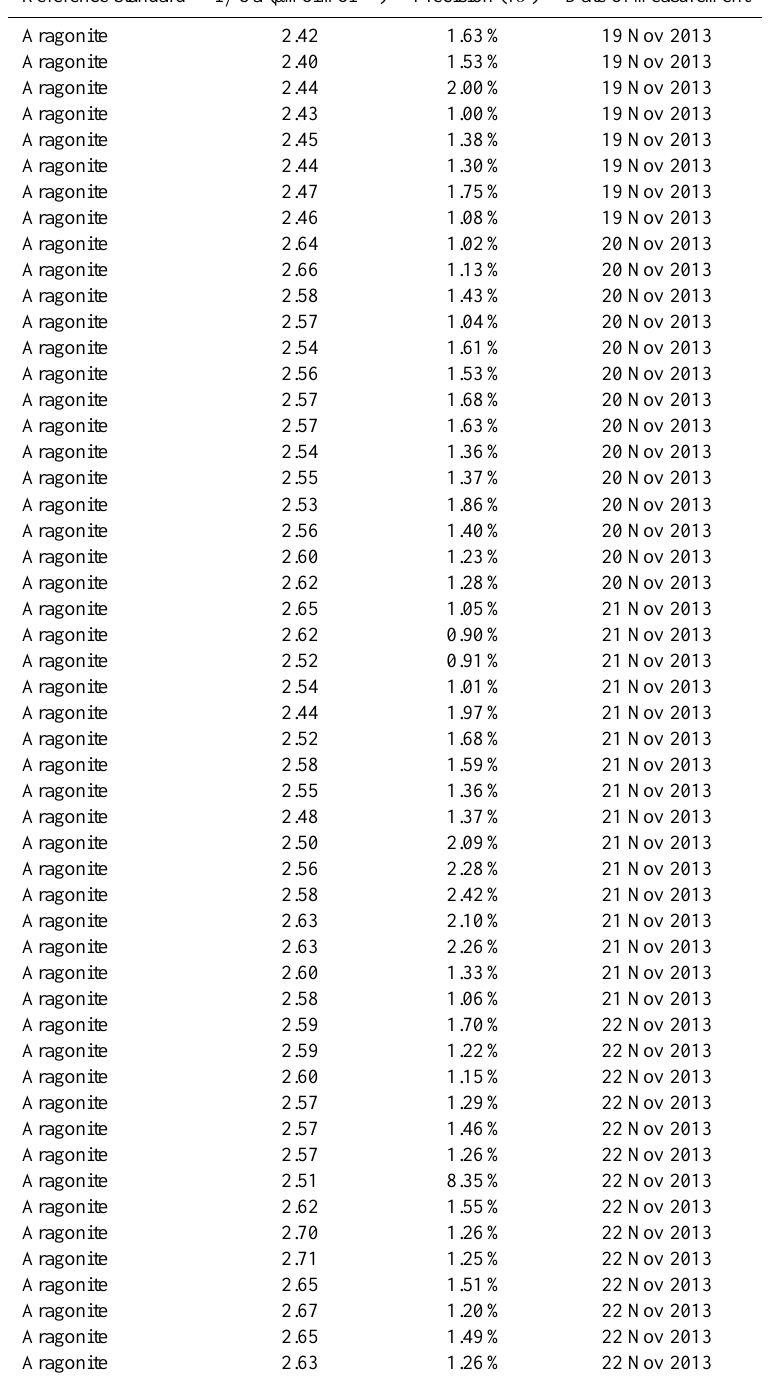
Table A1. I / Ca ratios and precisions for the single measurements of the internal reference standards. All measurements for the internal calcite reference standard ( n = 70) were below the detection limit, and are not listed in this